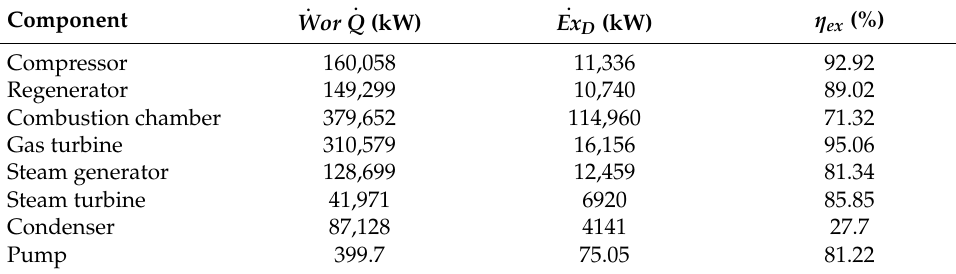
Table 10. Energy and exergy analysis of Config. 2.